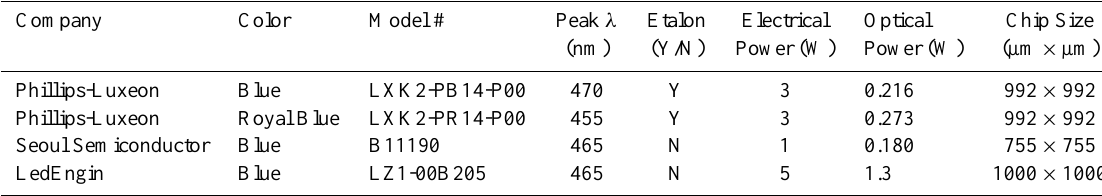
Table 2. Properties of LEDs that were tested in the blue spectral range. Company